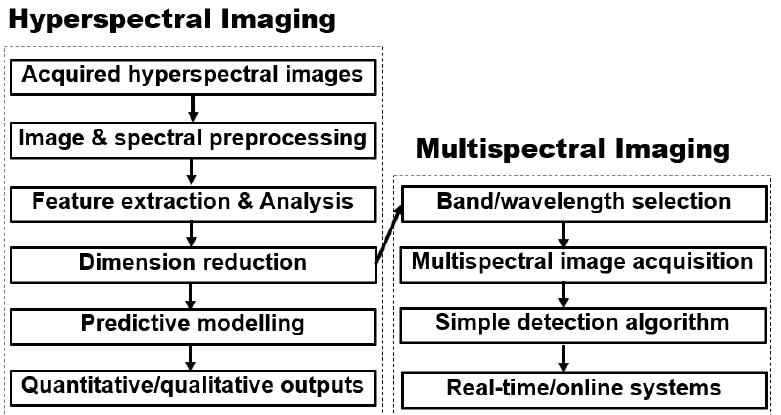
Figure 9. Hyperspectral imaging principle of operation.